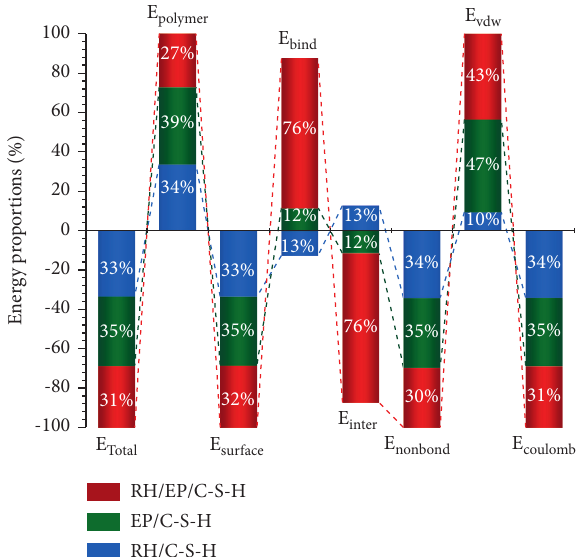
Figure 4: Percentage of energy of three